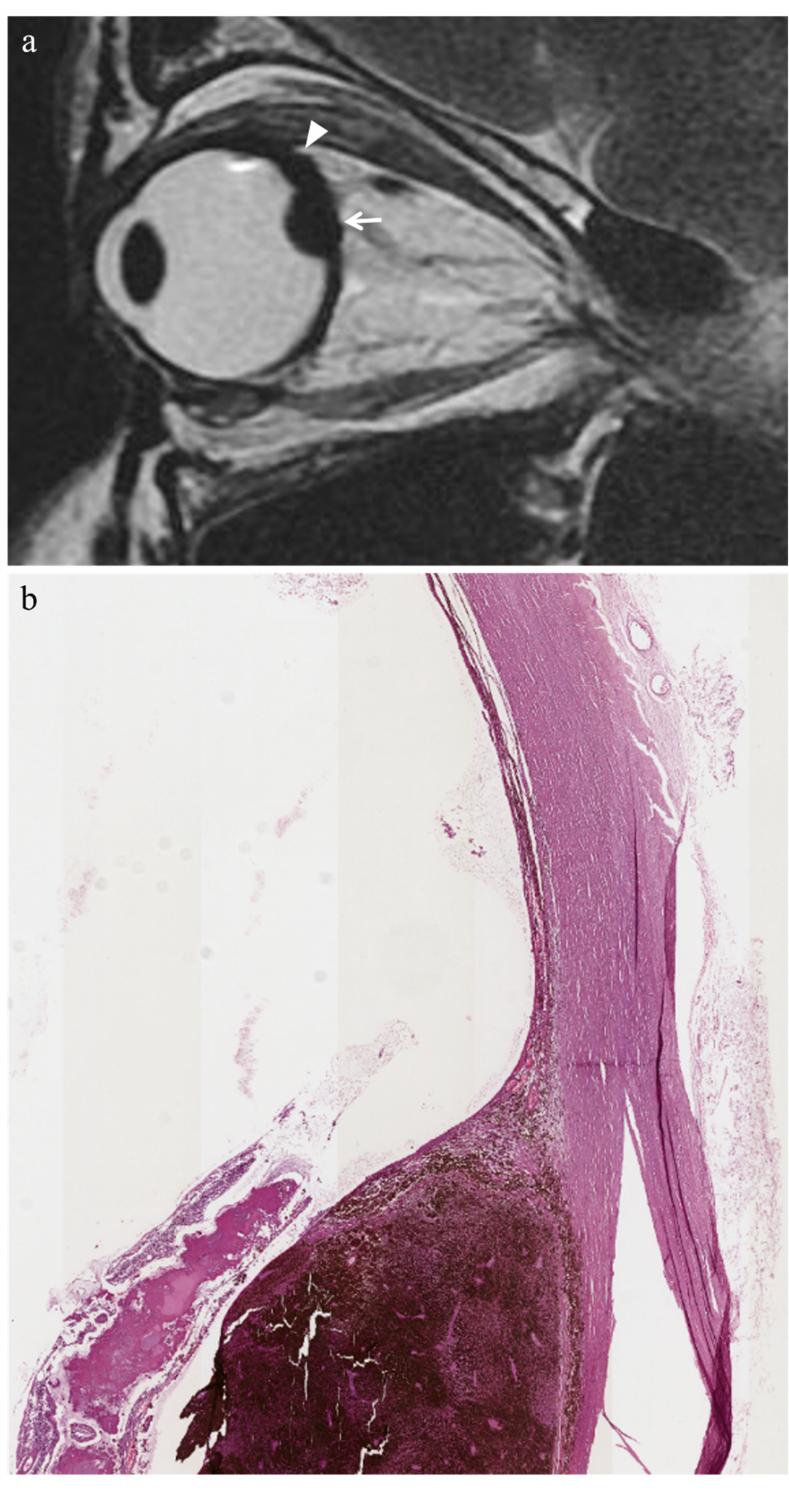
Figure 5. Periocular fibrotic adhesions. A 44-year-old male patient (patient n. 7 of our series) affected by choroidal melanoma of the right eye treated with proton beam radiotherapy. The same patient as in Figure 4. ( a ) Sagittal T2-weighted turbo spin-echo image demonstrates an intraocular choroidal melanoma (white arrow) along the postero-superior aspect of the globe. Hypointense soft tissue thickening (white arrowhead), due to fibrotic adhesions, is seen along the superior outer boundary of the sclera, adjacent to the lesion. ( b ) Histological detail (H&E, original magnification 50 × ) shows the moderate thickening and fibrosis of the sclera surrounding the tumor